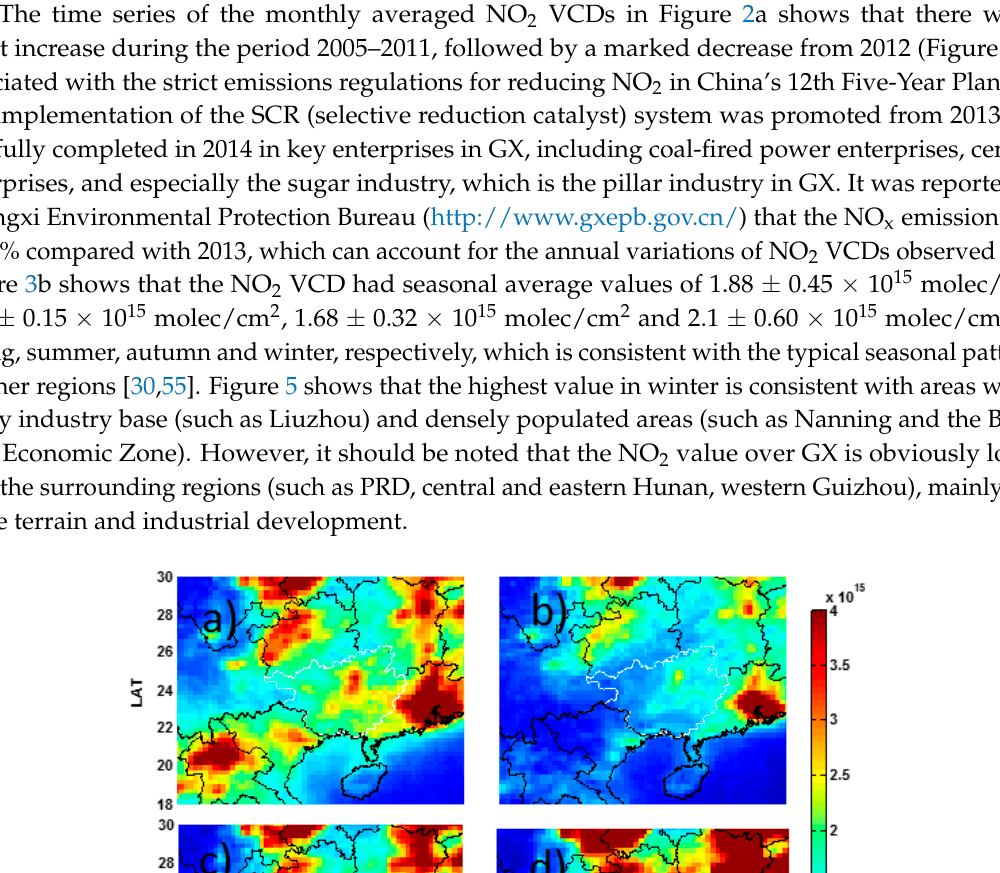
Figure 4. Seasonal-averaged OMI/MLS TCO for 2005–2016. ( a ) MAM; ( b ) JJA; ( c ) SON; ( d ) DJF.